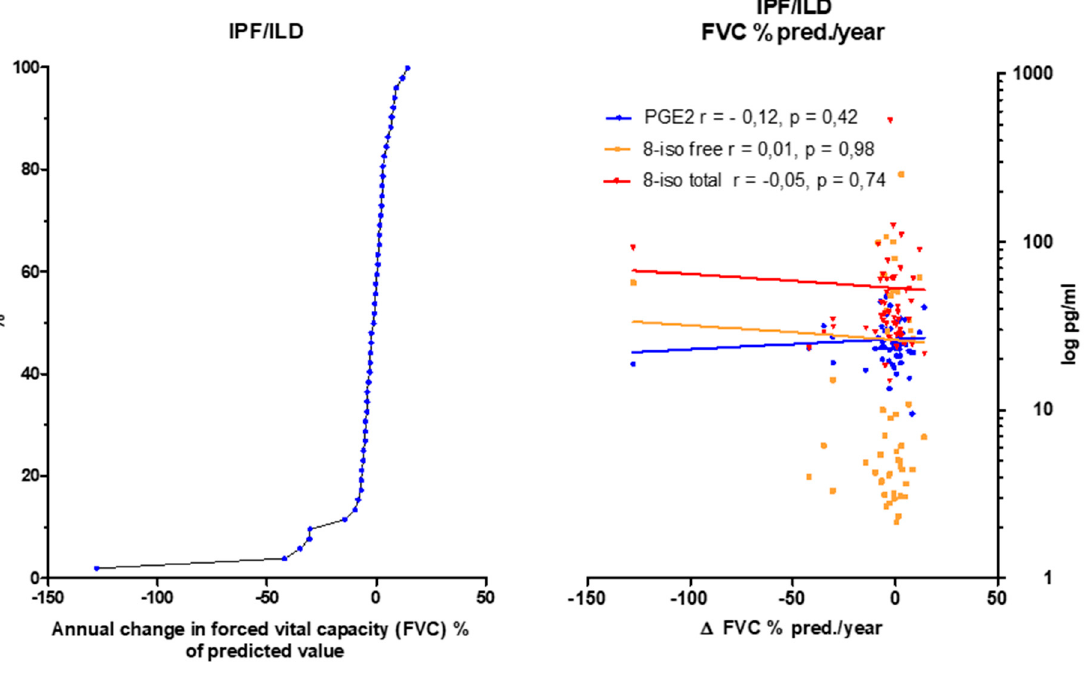
Figure 4. Correlation of the annual change in forced vital capacity (FVC; % of predicted value) in IPF and ILD patients and PGE2, total and free 8-isoprostane values in BALF. Left panel: The annual change of the FVC is summarized in the cumulative frequency diagram. Right panel: Correlation of FVC (% of predicted value) to PGE2 and 8-isoprostane. Abbreviations: FVC: forced vital capacity, PGE2: prostaglandine E2, r: correlation coefficient according to Spearman, 8-iso: 8-isoprostane. If data not available from all patients, the number(s) is specified.